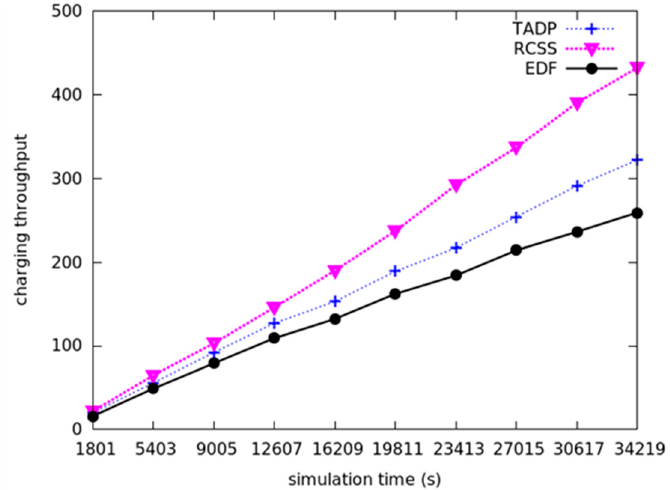
Figure 3. The comparison of charging throughput among RCSS, TADP and EDF.